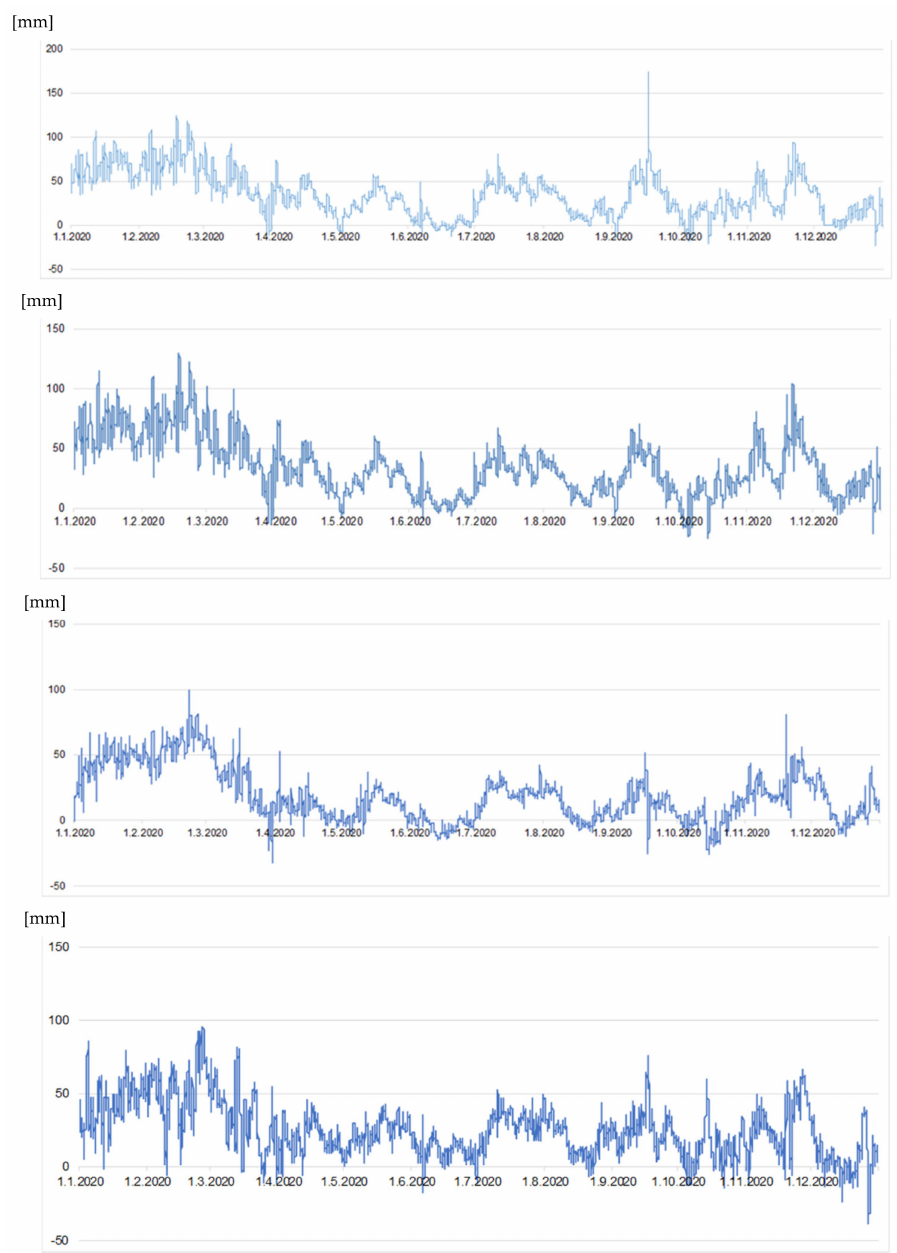
Figure 11. Hourly TG sea level time series (in millimeters) for Loksa, Estonia ( 1st row ), Emäsalo, Fin- land ( 2nd row ), Kobben, Sweden ( 3rd row ), and Władysławowo, Poland ( 4th row ) for the year 2020. The Gulf of Finland TG stations (Loksa and Emäsalo) at the opposite shores show good agreement; the average sea level is about +34 cm. On the other hand, during the time period in question, an upward spatial sea level gradient from west to east is identified in the Gulf of Bothnia TG stations. The sea level at the Finnish shore appears to be about 7–8 cm higher than the sea level at the Swedish TG stations. The adjacent Finnish TG stations Pori and Turku confirm the Rauma average sea level of +26 cm. Intuitively, such a west–east directional upward tilt (also higher than average sea level in the Gulf of Finland) can thus be due to prevailing (stronger and more frequent) westerly winds during the season in question. The 3 cm mean sea level difference (+22 versus +25 cm) for the adjacent Polish stations could have some local coastal circulation-related